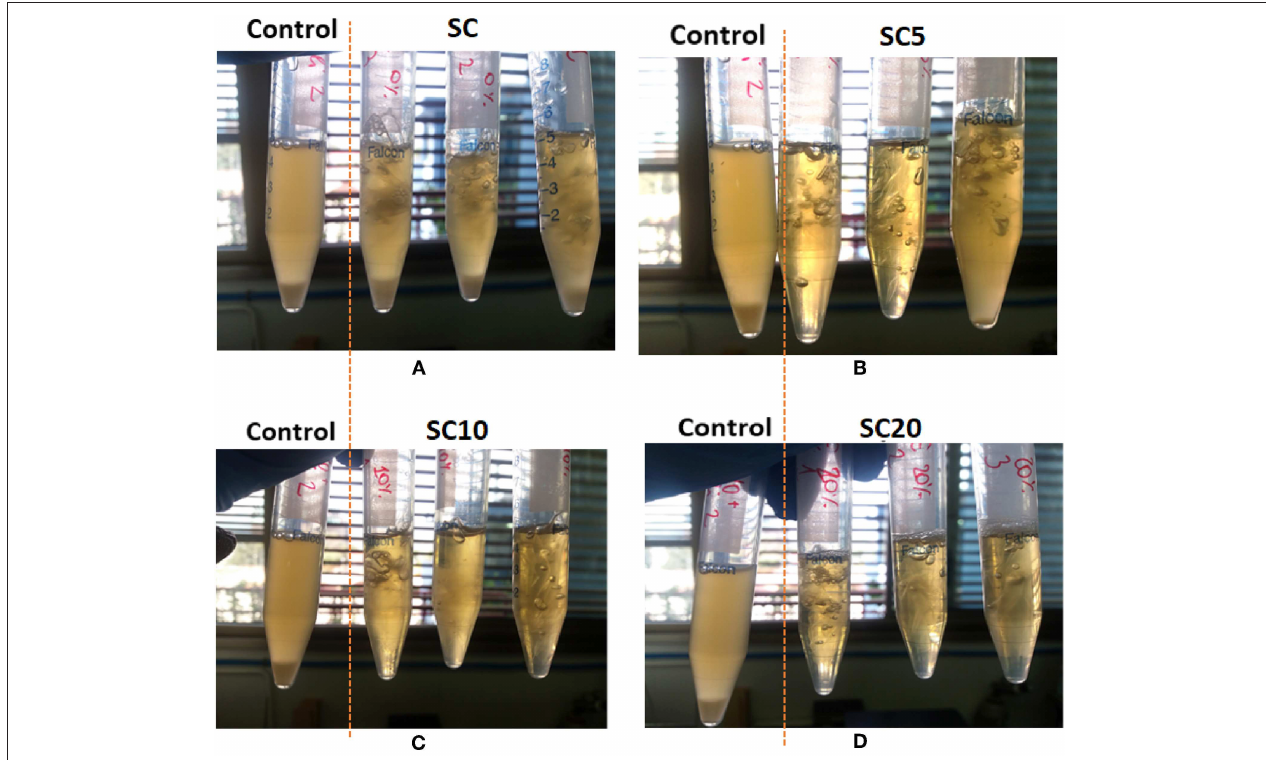
FIGURE 3 | Images of the tested safe-lock tubes inoculated with E. Coli and containing the SC coated films produced at different concentration of active agent: 0% LAE (A) , 5% LAE (B) , 10% LAE (C) , and 20% LAE (D) , after incubation at 37 ◦ C overnight, in comparison with the control sample.